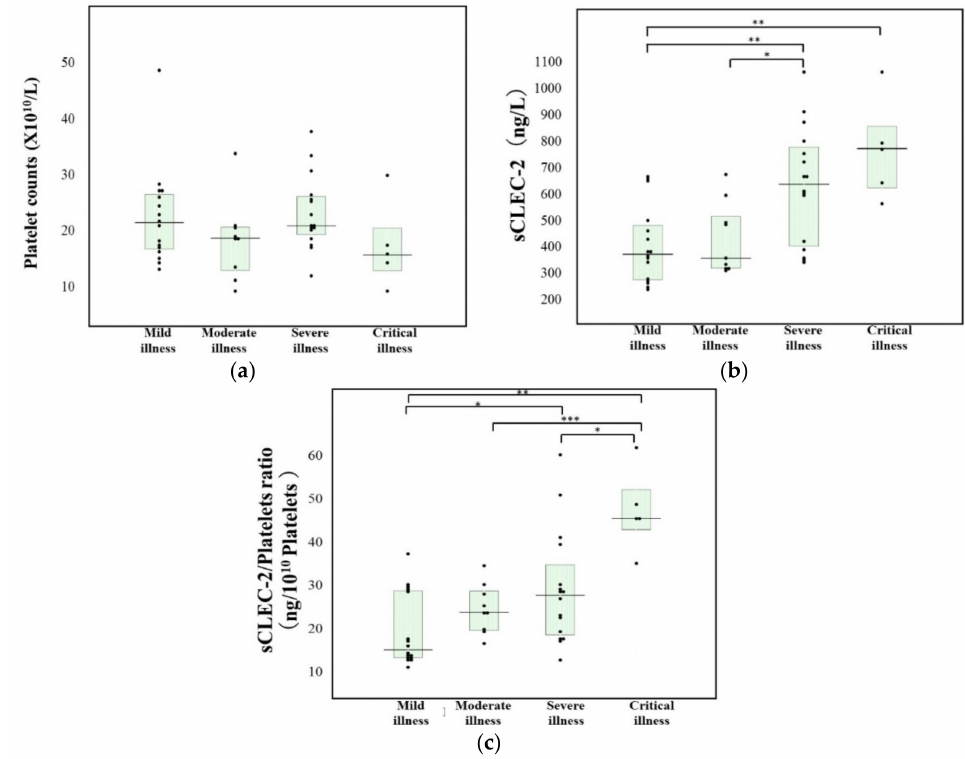
Figure 3. Platelets ( a ), sCLEC-2 ( b ) and the sCLEC-2/Platelets ratio ( c ) in patients with COVID-19 infection ***, p < 0.001; **, p < 0.01; *, p <